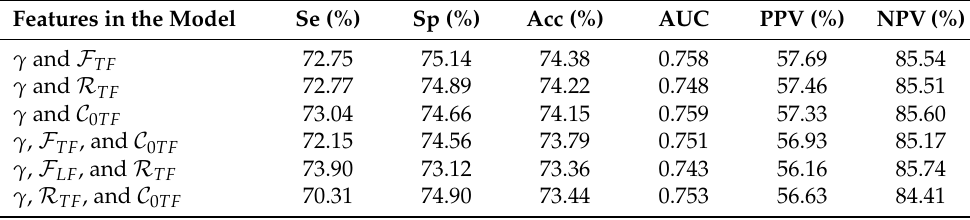
Table 4. Classification between patients who relapsed to AF and maintained SR during the follow-up provided by the prediction models obtained from multivariable linear discriminant